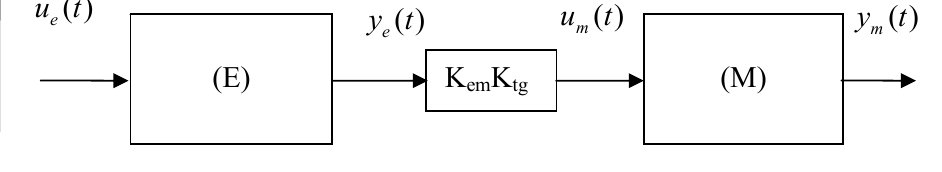
Figure 3 – DC motor represented by two first-order